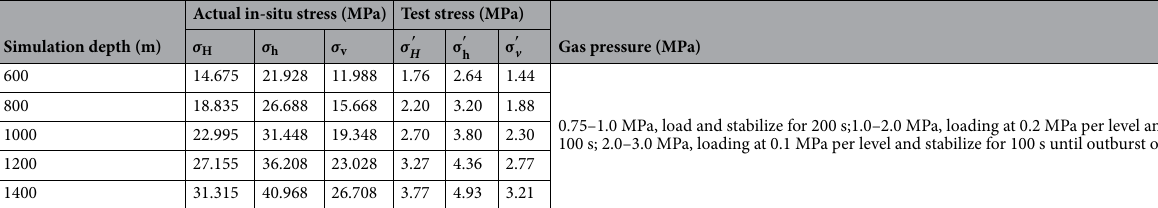
Table 1. Experimental scheme of coal and gas outburst.